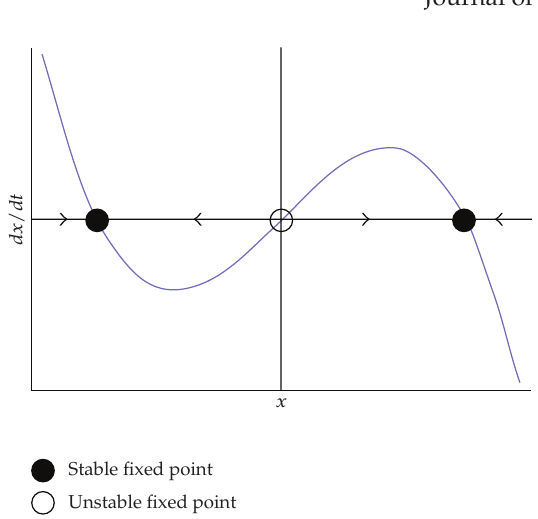
Figure 1: Transmission function when r (cid:8) 1 showing two stable and one unstable